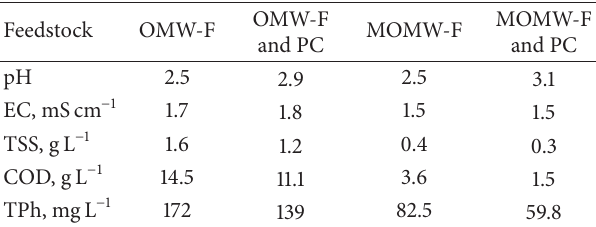
Table 3: Physicochemical composition of OMW and MOMW after flocculation (F) and photocatalytic (PC) degradation on pilot scale.